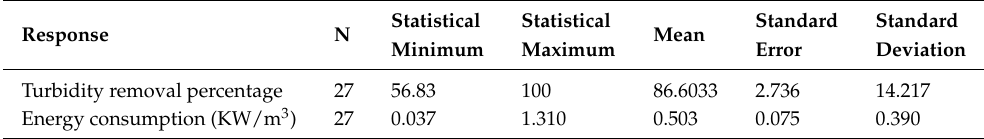
Table 5. Standard deviation of percent turbidity removal and energy consumption and Energy consumption.